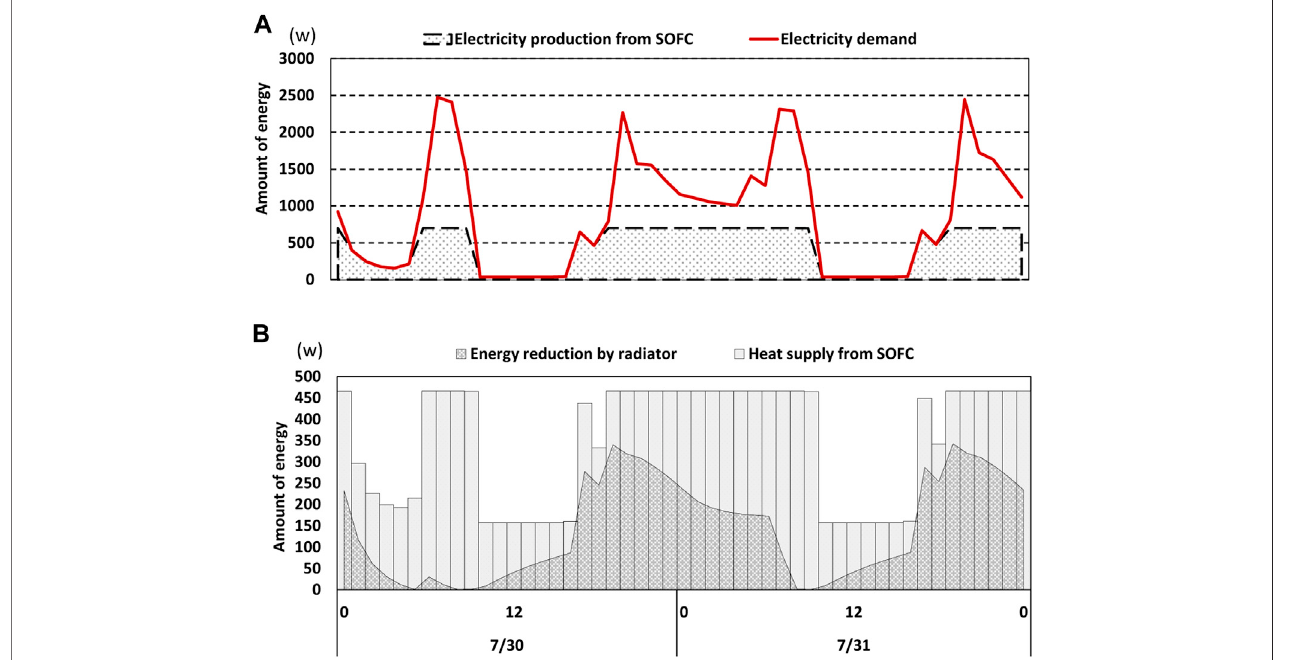
FIGURE 8 | SOFC – CGS simulation for Rooms 2 and 3: (A) electricity production and demand and (B) heat dissipation and usage.